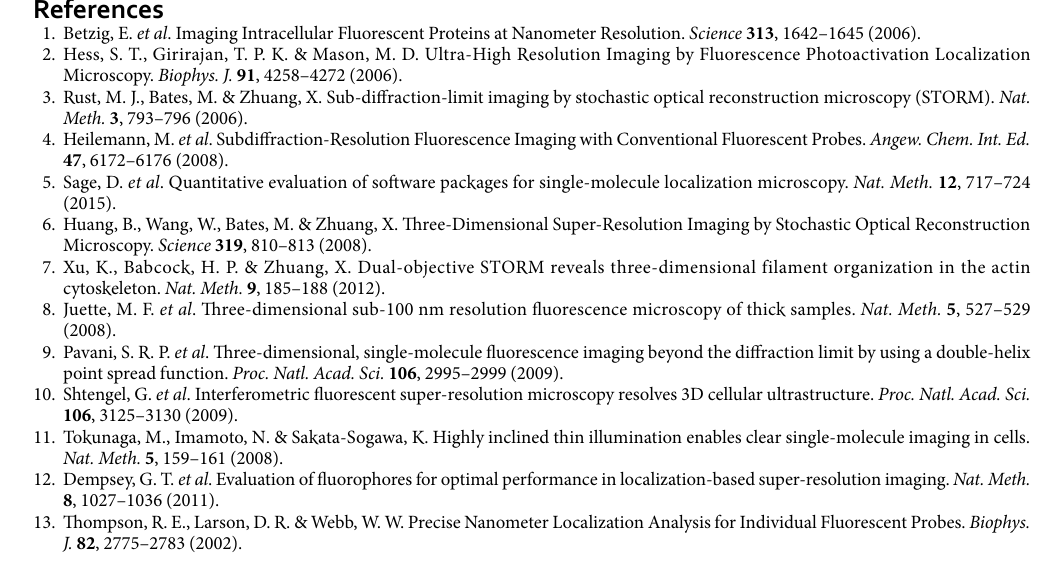
interface, and within 4 minutes, the majority of LAT vesicles are located at approximately 150 nm above the mem- brane. By 8 minutes, the majority are located within 100 nm of the membrane. The large-scale recruitment of vesicles to close proximity of the plasma membrane, combined with the plasma membrane clusters themselves, creates an aggregated 3D signalling platform. This is evidenced by the observed increase in cluster radii, an increase in the number of localisations per cluster and the depopulation of clusters from deeper regions. We also observe an increase in the total number of localisations after activation, which could be the result of recruitment of vesicles between 4 and 8 minutes from beyond the imaging depth. A proposed model for the recruitment of LAT vesicles is shown in Fig. 5 and previous studies have shown that such a recruitment of LAT containing vesi- cles is dependent on the SNARE Vamp7 39 . While our data is consistent with the recruitment of LAT vesicles to the immune synapse from an intracellular pool, it does not discount the possibility of additional vesicles generated by membrane endocytosis. In fact, our data suggests the possible generation of LAT vesicles by endocytosis as evidenced by the small decrease in the number of LAT clusters at the plasma membrane post-activation. In conclusion, we have developed a cluster analysis method for 3D SMLM data, and tested its applicability using simulated data as well as iPALM imaging of LAT organization in T cells. In the future, 3D SMLM will become more widely available and used routinely in the context of biological sciences as it provides a more accu- rate insight than conventional 2D SMLM which consists of a 2D projection of a 100 nm thick volume. While we have implemented a simple Bayesian model here, in principle, other more complex models are possible, for exam- ple, top-hat profile clusters or ellipses. Techniques such as these will allow SMLM to transition from providing visual illustration of the nanoscale architecture to providing reliable quantitative information and statistics for complex biological studies.